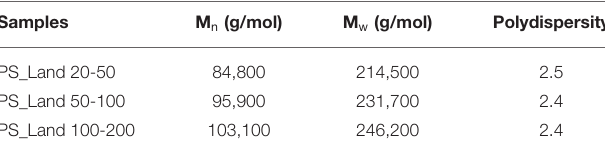
TABLE 2 | Gel permeation-chromatography measured molecular weights of polystyrene samples.